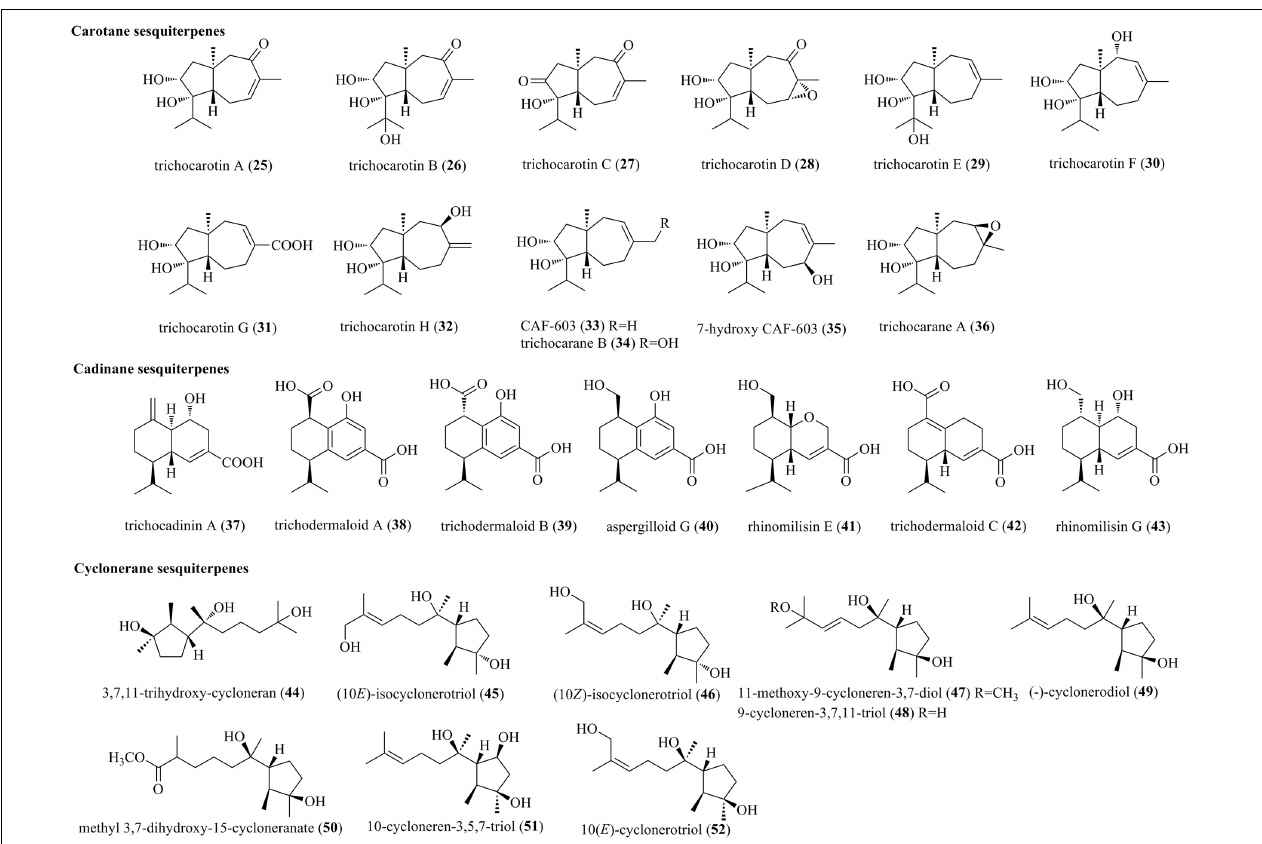
FIGURE 2 | Carotane, cadinane, and cyclonerane sesquiterpenes produced by Trichoderma species ( 25–52